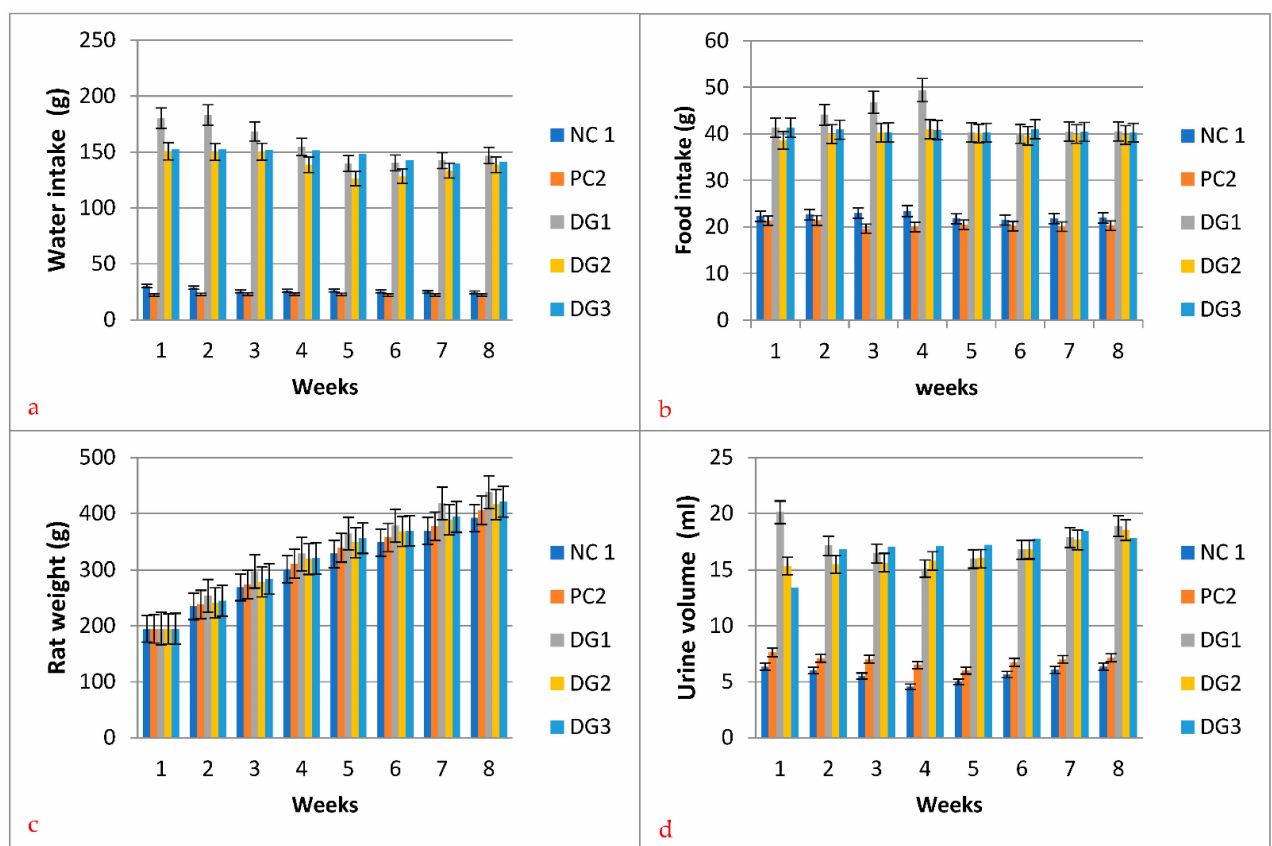
Figure 10. Effect of the nano-aqueous extract C. roseus and commercially available medicine (with n = 10 for each group) on ( a ) water intake, ( b ) food intake, ( c ) rat weight, and ( d ) urine